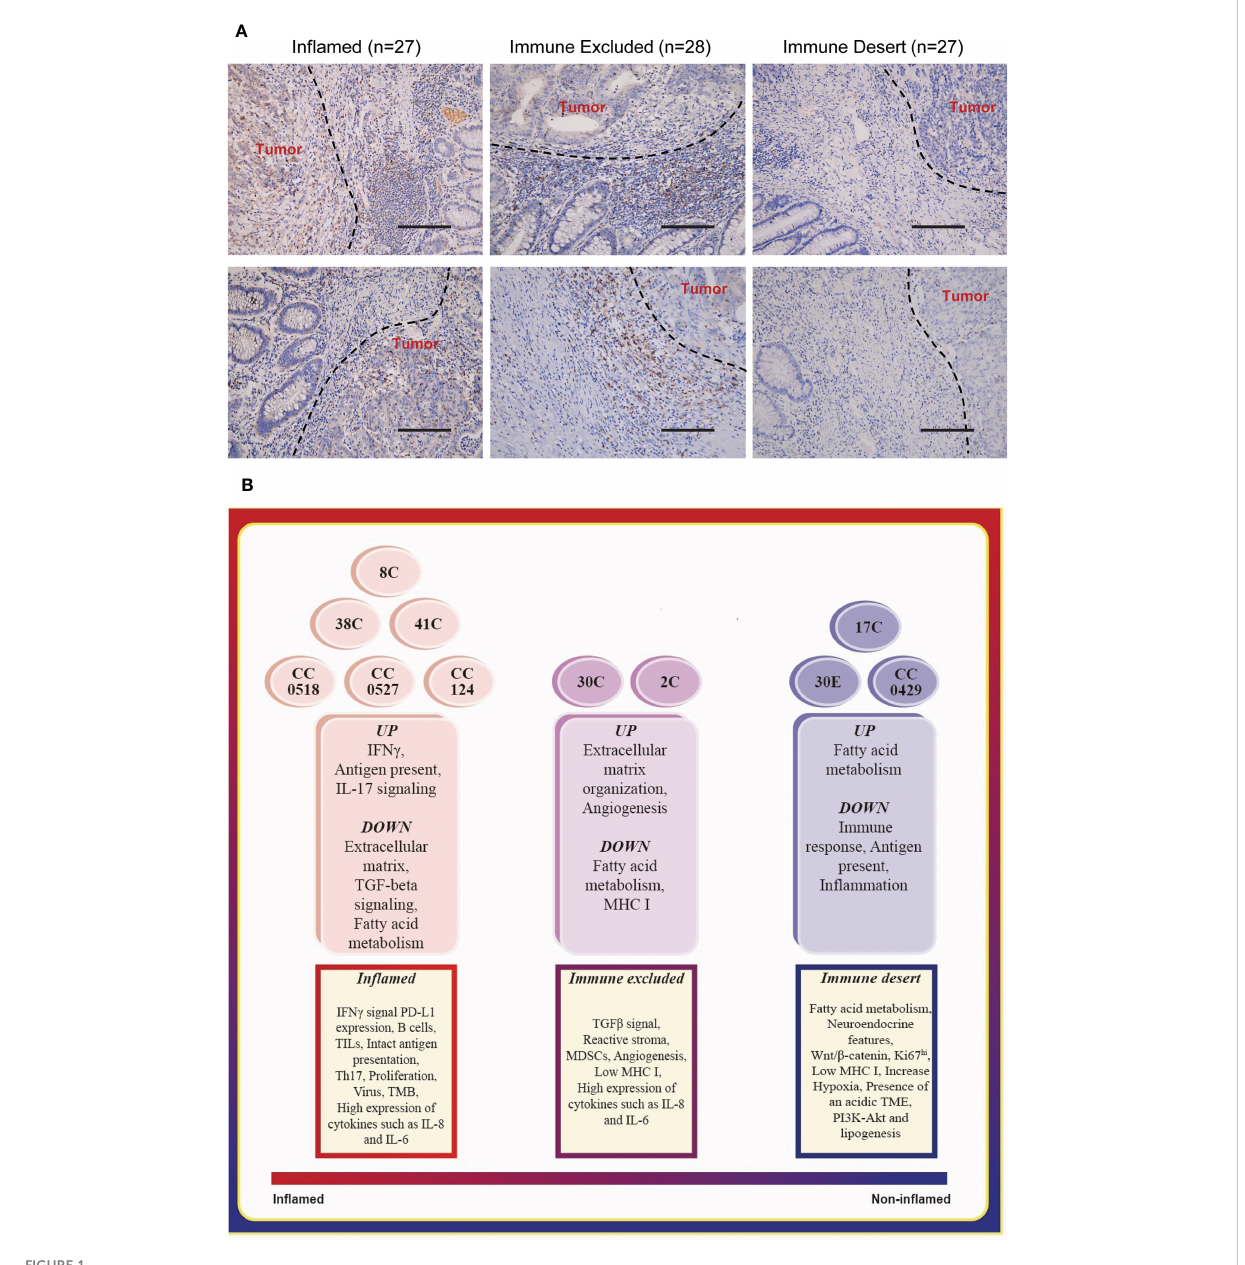
FIGURE 1 Typing the tumor immune signatures in MMR-de fi cient tumors with histology and transcriptome pro fi le, respectively. (A) The representative images of immunohistology of CD8 staining on MMR-de fi cient tumors exhibit the patterns of all three tumor immune signatures: immune desert, immune excluded, and in fl amed. Magni fi cation: 50×, scale bar: 100 m m. (B) Functional enrichment of mRNA expression pro fi le suggests the basic features of the three tumor immune